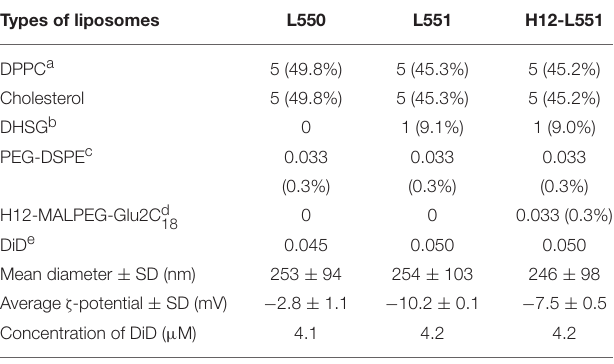
TABLE 1 | Formulation in molar ratio (mol%) and characterization of liposomes. Types of liposomes